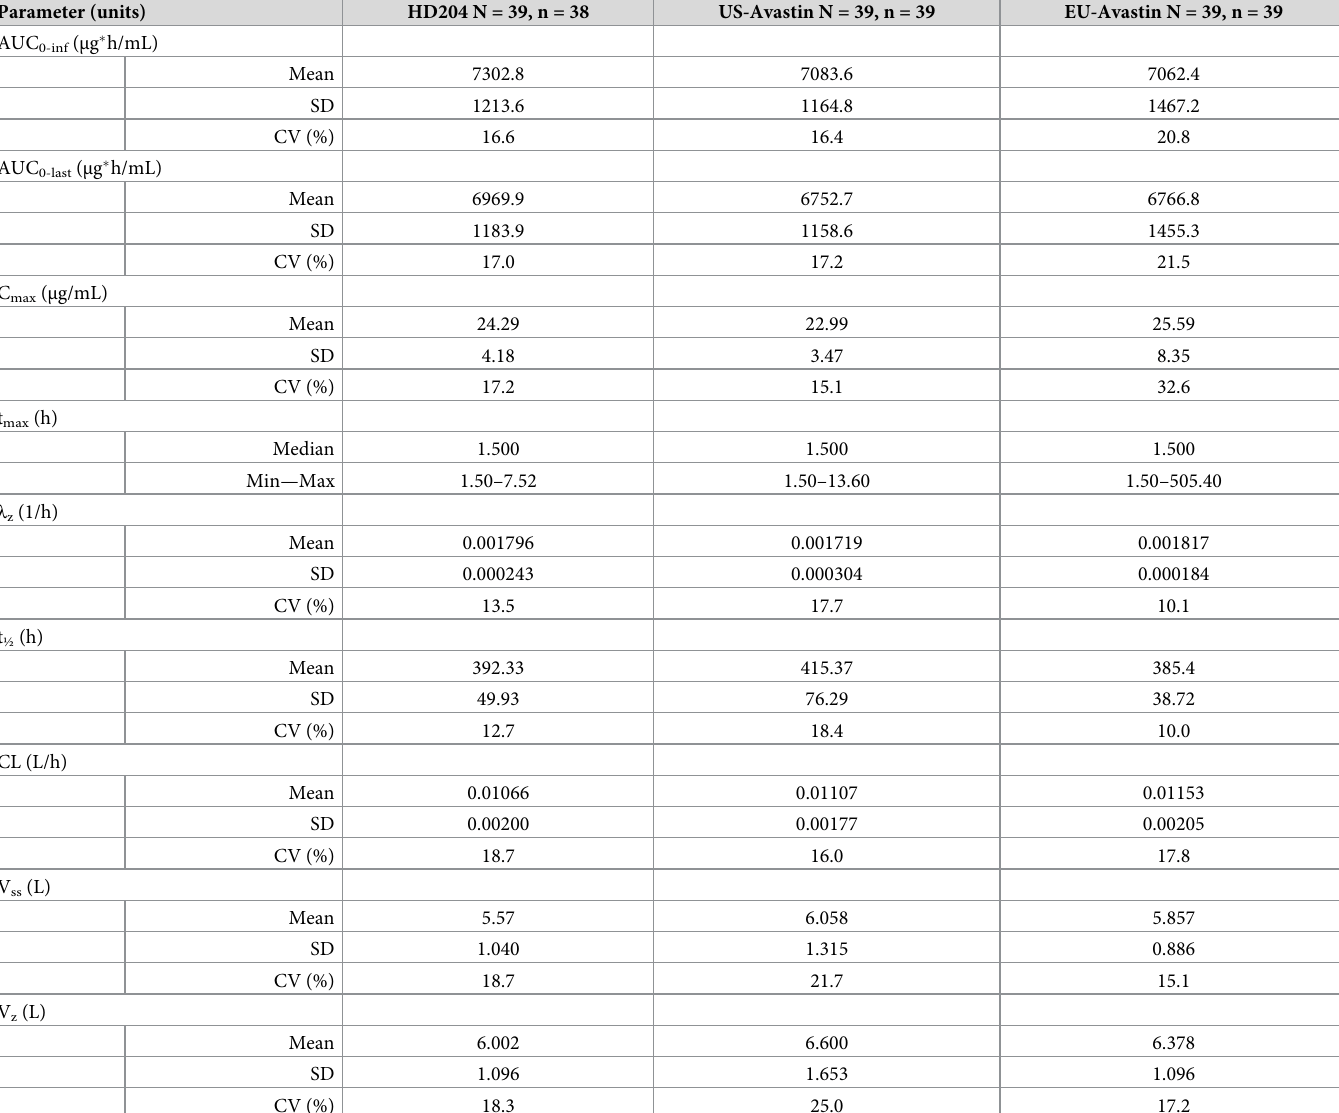
Table 2. Summary of PK parameters for bevacizumab (PK